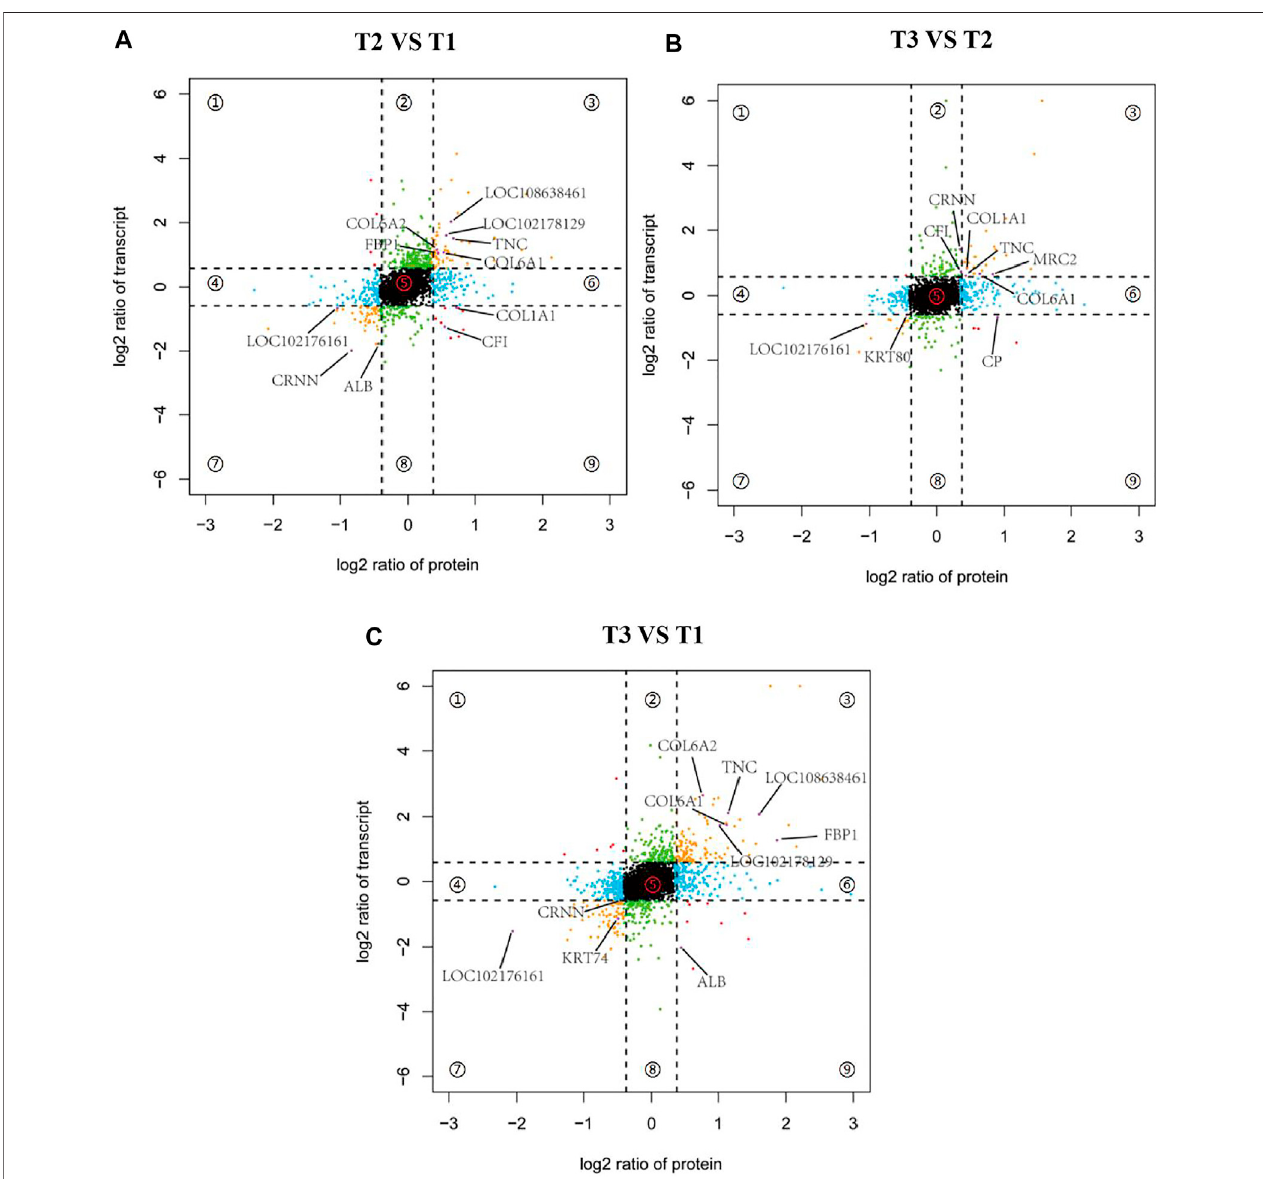
FIGURE9| Nine-quadrantdiagramofdifferentiallyexpressed genesbetweentranscriptomeandproteome. Quadrants 1and9indicatethattheexpression trends of the two omics are opposite. Quadrants 2 and 8 indicate genes that only express differences in the transcriptome. Quadrants 3 and 7 indicate that the expression trends of the two omics are consistent. Quadrants 4 and 6 Indicates that only differentially expressed proteins are expressed in the proteome, and quadrant 5 indicates genes that are not expressed in both omics. (A) T2 VS. T1. (B) T3 VS. T2. (C) T3 VS. T1.